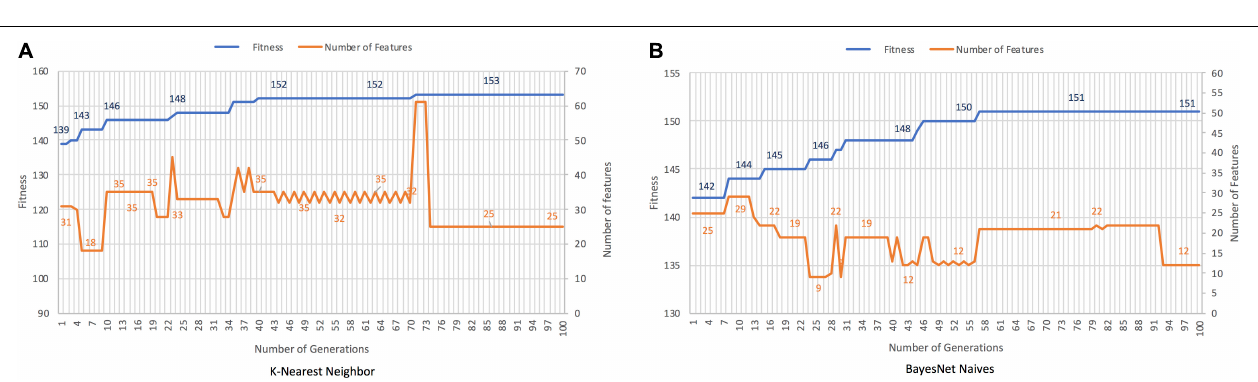
FIGURE 4 | Results for bvFTD vs. HC with K-Nearest Neighbor (A) and BayesNet Naives (B) as the fitness function. The X axis represents the generation, the main Y axis corresponds to the fitness value, and the secondary Y axis shows the number of features selected. The blue line represents the progression of fitness and the orange line the smallest set of features in the current generation.